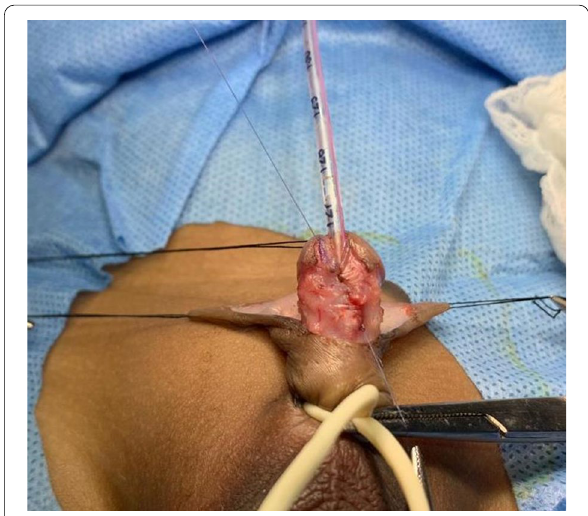
Fig. 3 Urethroplasty with 6–0 PDS being performed from the proximal to distal end